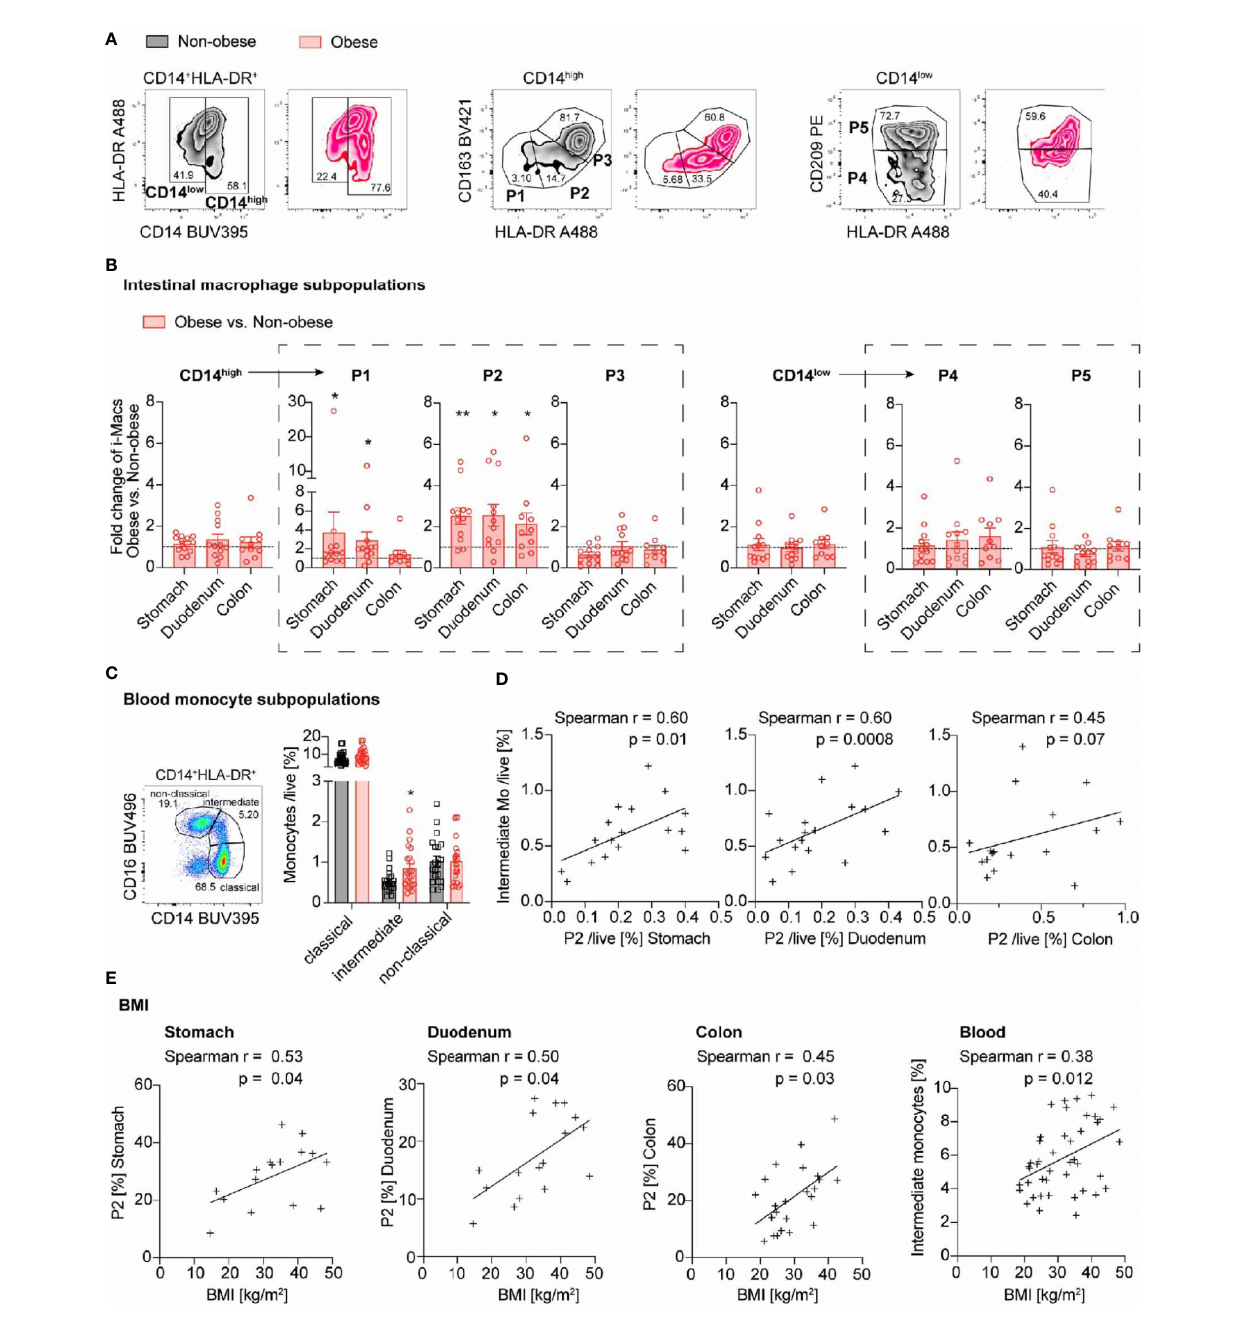
FIGURE 3 | Pro-in fl ammatory macrophages increase throughout the gastrointestinal tract in obese individuals and are accompanied by higher intermediate blood monocytes. (A) Representative fl ow cytometry plots identifying intestinal macrophages subpopulations in non-obese (black) and obese (red) individuals. CD14 high represent pro-in fl ammatory P1, P2 and intermediate P3 subpopulations and CD14 low anti-in fl ammatory/resident P4, P5 subpopulations. (B) Fold change of intestinal macrophage subpopulations comparing obese (n = 10-12) to non-obese (n = 12-13) subjects along the gastrointestinal tract. (C) Frequency of classical, intermediate, and non-classical blood monocytes in non-obese (black; n = 22) and obese (red; n = 25) subjects. (D) Spearman correlation between intestinal macrophage subpopulation P2 in stomach, duodenum or colon and intermediate blood monocytes. (E) Spearman correlation of intestinal macrophage subpopulation P2 in stomach, duodenum, and colon transversum or intermediate blood monocytes with BMI. One data point represents one subject. Statistical data are expressed as mean ± SEM. * p <0.05. ** p <0.01, unpaired Mann-Whitney U test with two tailed distribution (B, C) . For Spearman correlation analysis, values above Mean + 2SD were excluded (D, E)